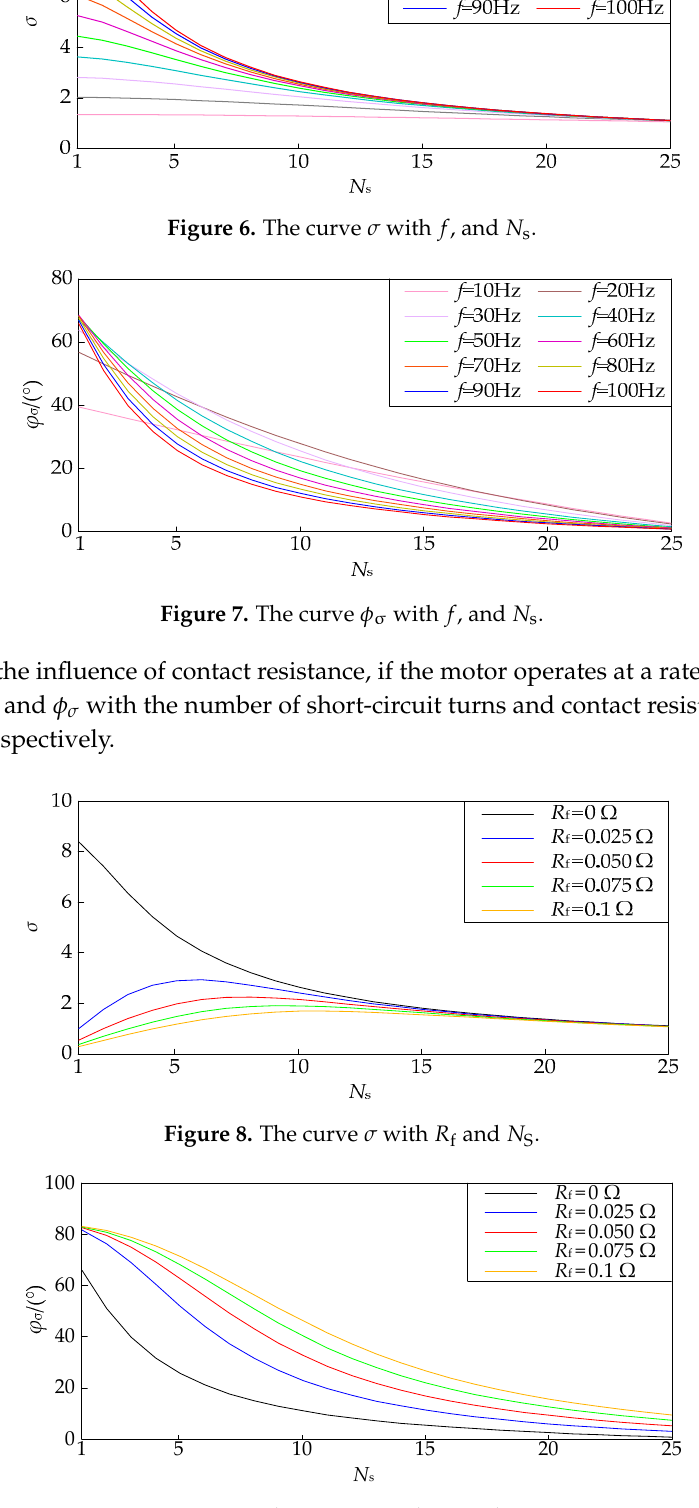
R and N . Figure 9. The curve σ with R f and N S f S R and N . f S R and N . f S R and f